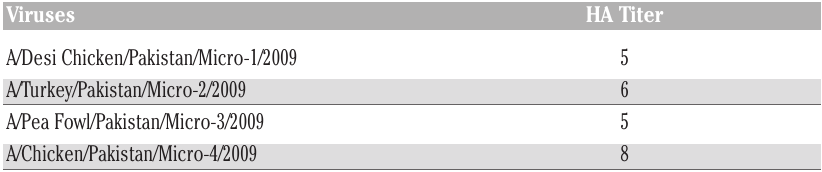
Table 2. Hemagglutination titer of the harvested